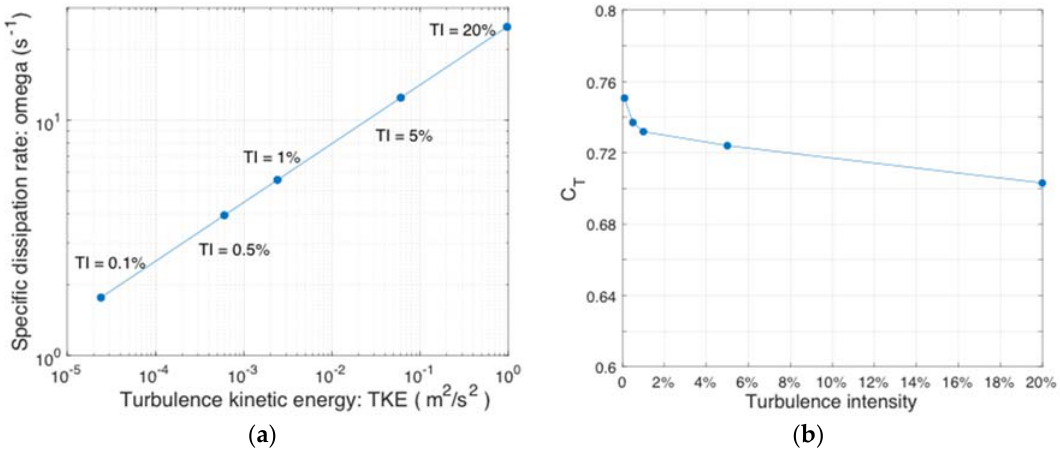
Figure A3. Inlet turbulence conditions and their e ff ects on the vertical-axis turbine model for TI = 0.1%, 0.5%, 1%, 5%, and 20%: ( a ) specific dissipation rate ( ω ) versus turbulence kinetic energy (TKE or k ), and ( b ) thrust coe ffi cient versus TI.